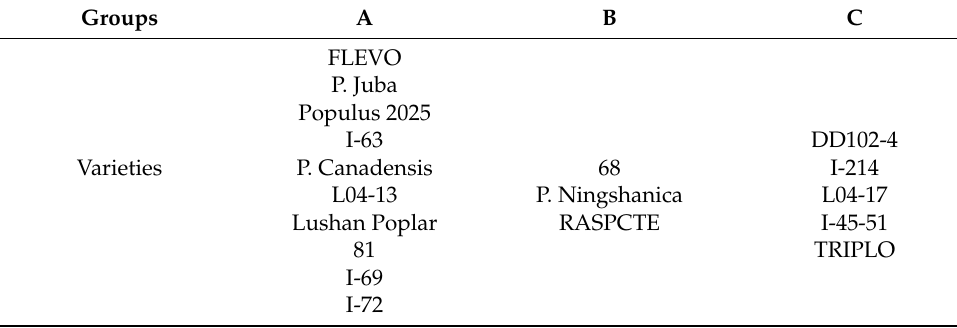
Table 5. The result of poplar varieties